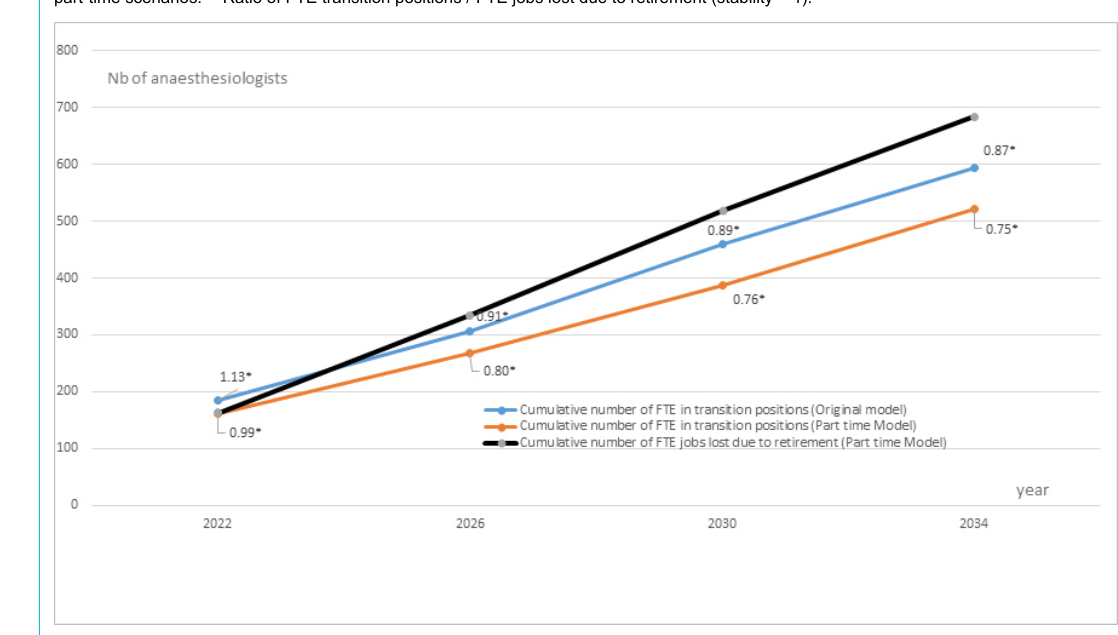
Figure 5: Cumulative change over time in the number of full-time equivalent (FTE) transition positions according to original and increased part-time scenarios. * Ratio of FTE transition positions / FTE jobs lost due to retirement (stability =